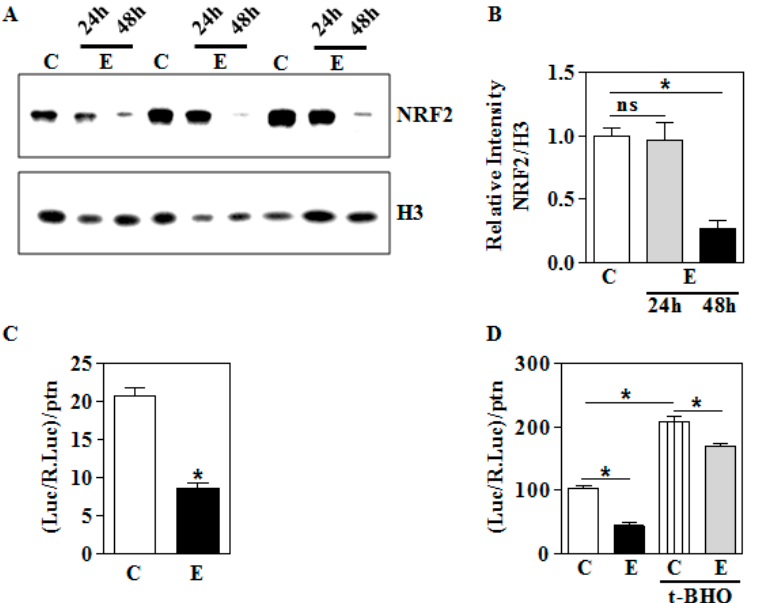
Figure 5. Effect of in vitro ethanol exposure on the nuclear levels of NRF2 and its transactivation ability. HTR8/sv neo trophoblasts were treated with E (4 mg/mL) as indicated in Section 2.2. ( A ) The protein levels of NRF2 in the nucleus were determined by immunoblot analyses and equal loading was assessed by anti-H3; ( B ) the densitometric scanning analysis ratio of NRF2 to H3 band intensities was performed using NIH ImageJ analysis; ( C ) cells were transfected with luciferase construct containing NRF2-binding ARE sequences with 4 tandem repeats along with pRL-renilla construct as detailed in Section 2.4. NRF2 transactivation was determined in terms of luciferase normalized to renilla and to protein ( n = 12); ( D ) cells were transfected and processed as in ( C ) but for t-BHQ pretreatment for 24 h ( n = 12). Values represent the mean ± SEM. * p < 0.05 was considered significant versus ethanol.